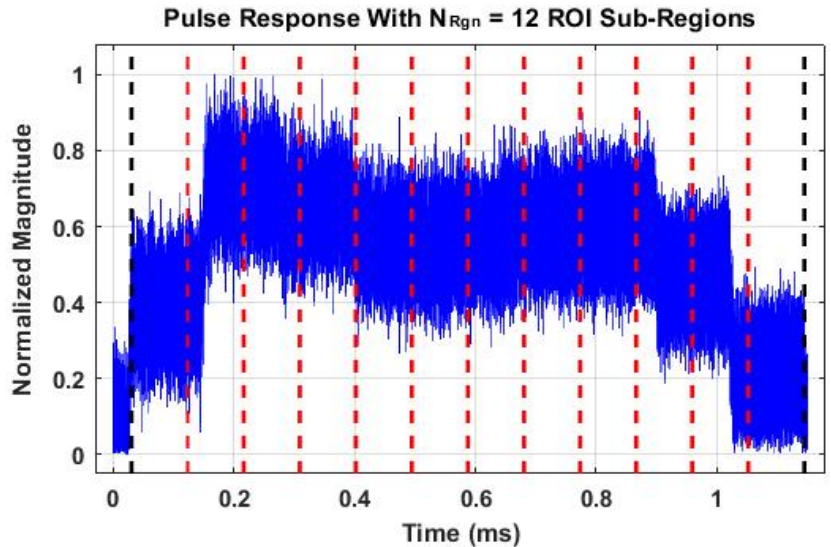
Figure 3. Normalized time domain magnitude of a representative DUT stimulated output showing the full ROI (bounded by black dashed lines) and the N Rgn = 12 subregion boundaries used for generating statistical time domain DNA fingerprint features.